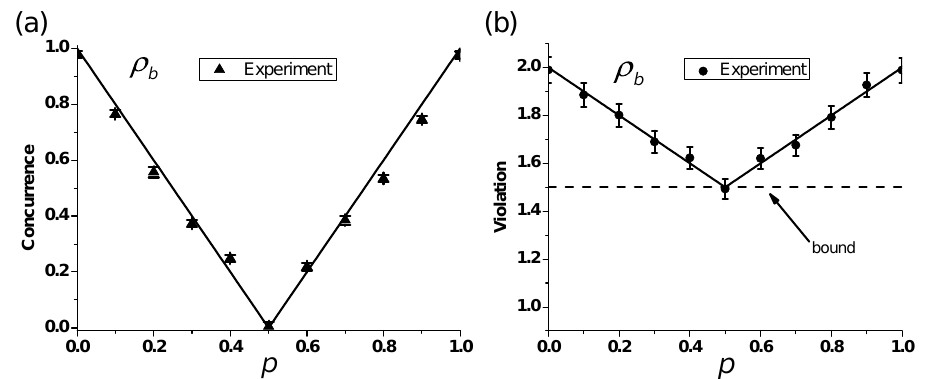
Figure 4. Experimental results of Bell diagonal states. ( a ) Experimental concurrence as a function of the parameter p for different Bell diagonal states ρ b . The triangle symbols represent the experimental data. Solid line represents the theoretical prediction. Error bars are obtained based on assuming Poisson statistics. ( b ) Experimental violations of FGS inequality as a function of p . The circular symbols represent the experimental data. Solid lines represent the theoretical prediction. The dashed line represents the bound of violation of FGS inequality. Error bars are due to the statistical uncertainty. The experimental results match well with theoretical